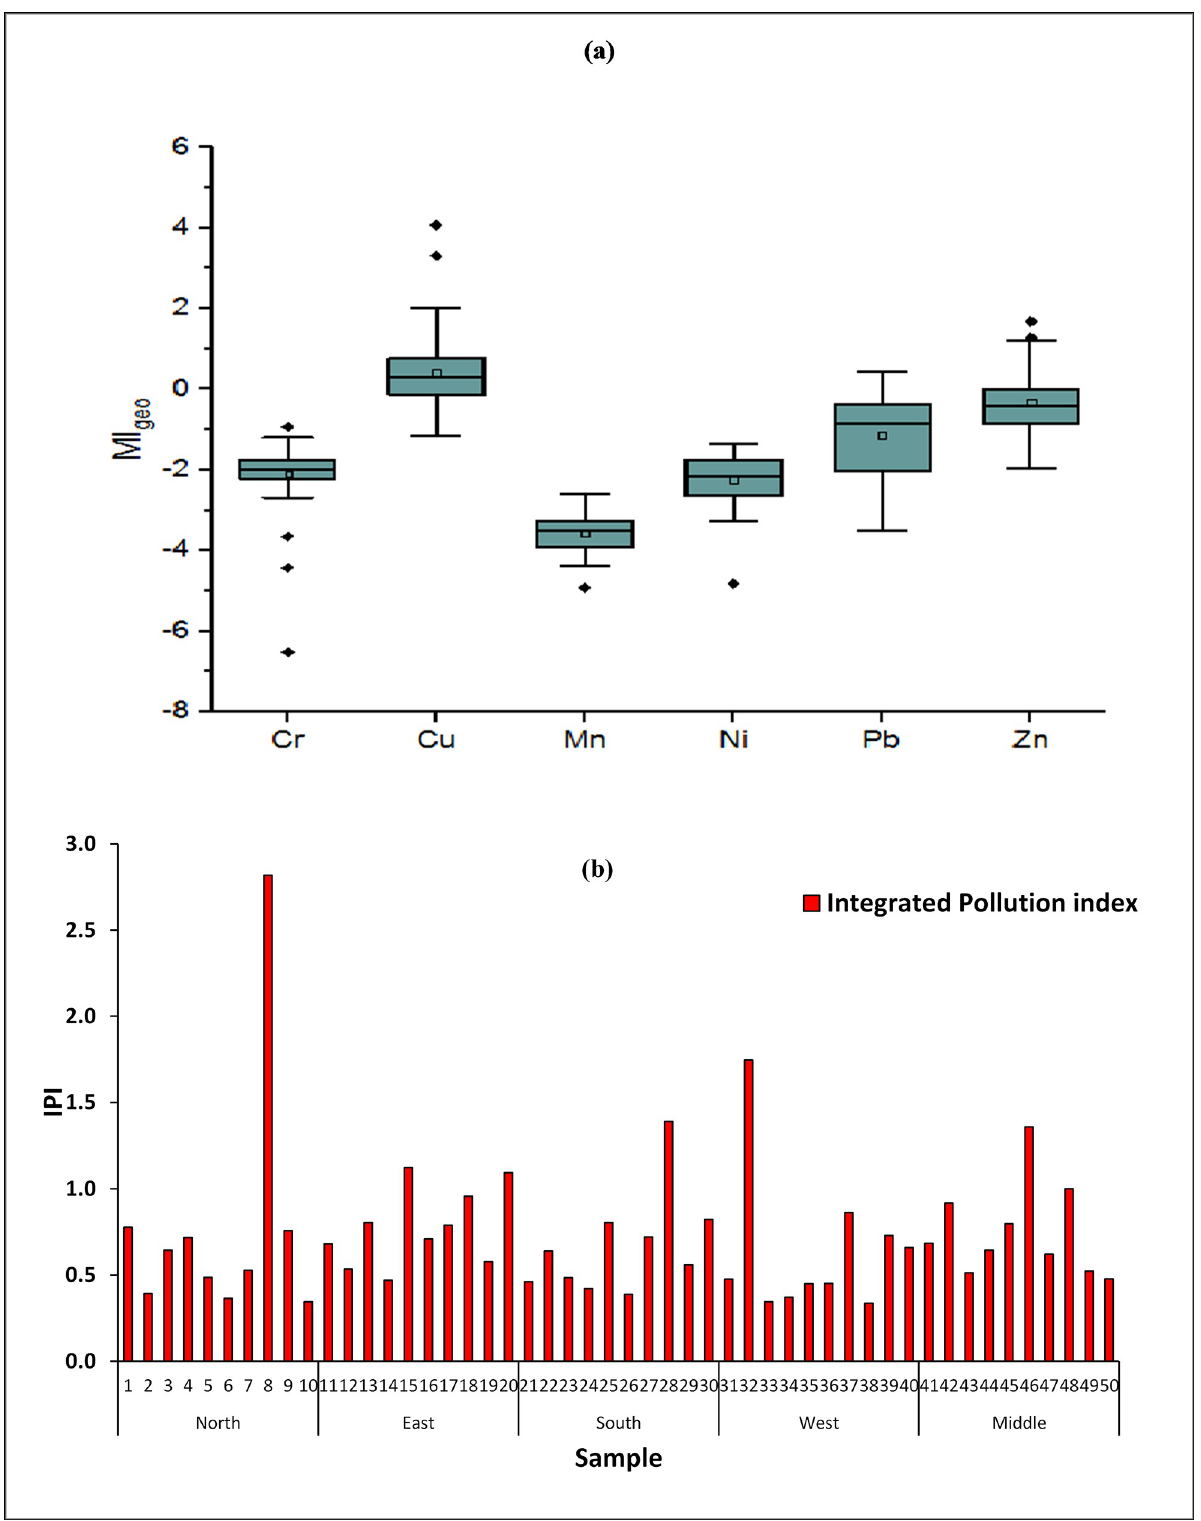
Fig 5. (a) Geological Accumulation Index and (b) Integrated Pollution Index of collected air dust samples in Riyadh City.